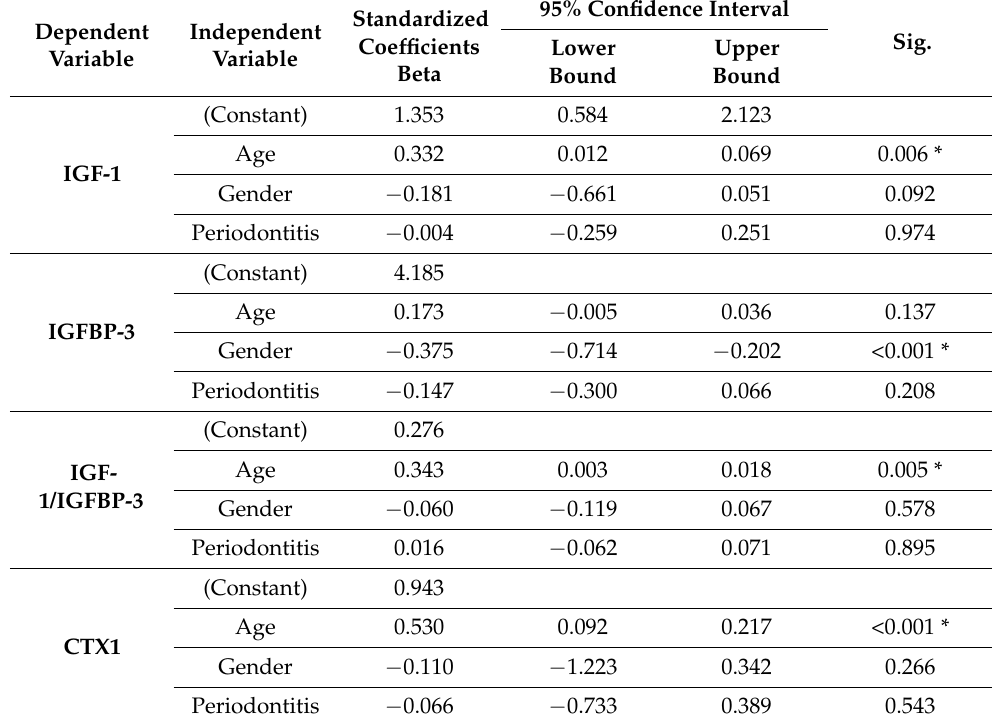
Table 5. Multiple regression of age, gender, and periodontal conditions with the levels of the biochemical parameters. Dependent Independent Variable Variable